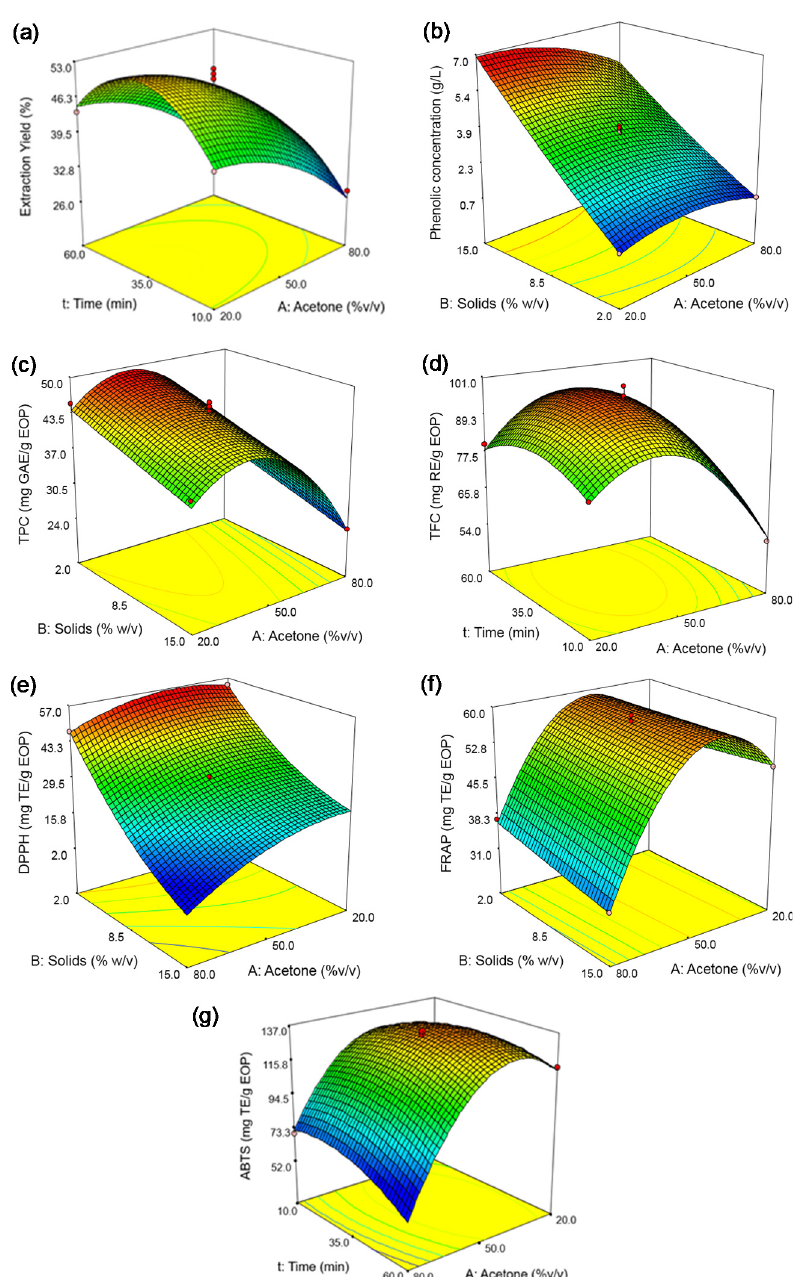
Figure 2. Response surfaces obtained by the Box–Behnken design for exhausted olive pomace: ( a ) extraction yield, ( b ) phenolic concentration, ( c ) total phenolic content (TPC), ( d ) total flavonoid content (TFC), ( e ) DPPH assay, ( f ) FRAP assay, and ( g ) ABTS assay. The solid loading was fixed at 8.5% in plots ( a , d , g ), and the time at 35 min in plots ( b , c , e , f ). The values of TPC are comparable to that of olive tree biomasses [11,30,40], including commercial olive leaves, e.g., the phenolic content ranged between 20.6 and 108 mg/g dry biomass. Olive leaves are currently used to obtain marketable functional extracts (pow- dered and liquid extracts), which showed a high heterogeneity in the levels of phenolic compounds (7.5–250 mg/g of extract) and oleuropein represented up to 94% of total phe- nolic compounds [31,41]. In this work and considering the experimental assays in Table 3, the values could vary between 63.1 mg/g of extract (run 12) and 112.1 mg/g of extract (run 5), which was also in the range of the latter values.